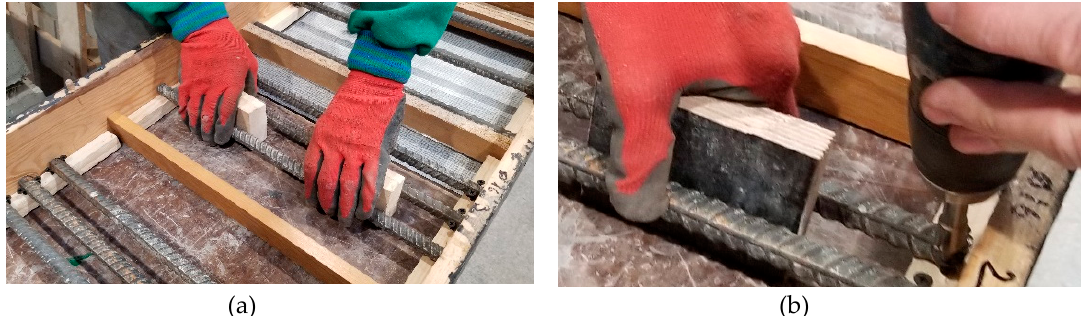
Figure 7. Stabilization of reinforcement in formwork: ( a ) distance resulting from wooden spacers, ( b ) rebar fastening to wooden washers with screws.